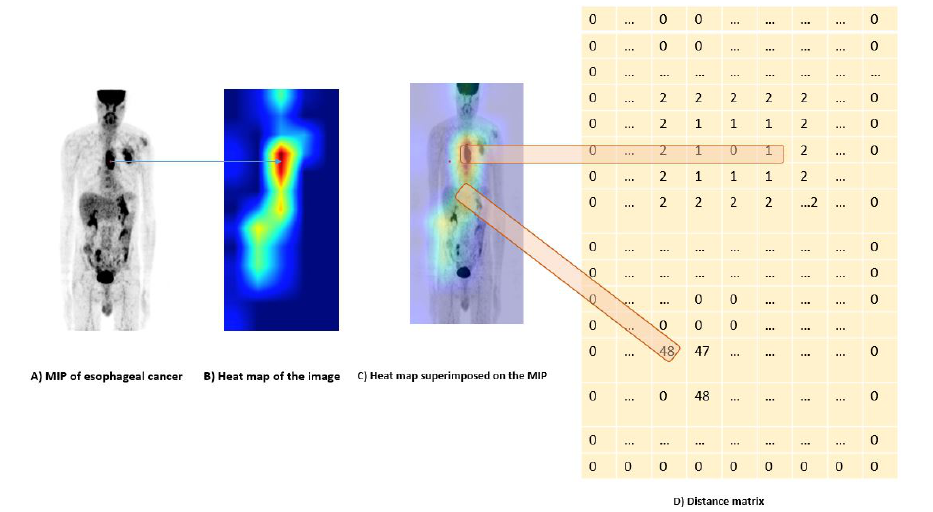
Figure 8. Distance matrix between p at the center of the tumor and the points q i generated by the heat map. ( A ) is a Coronal MIP for a patient with esophageal cancer. A point p is randomly defined at the tumor region. ( B ) is the heat map generated using our proposed model. ( C ) shows the overelay of the MIP and the heat map. ( D ) is the distance matrix showing the distance between the points q i generated by the heat map and the point p